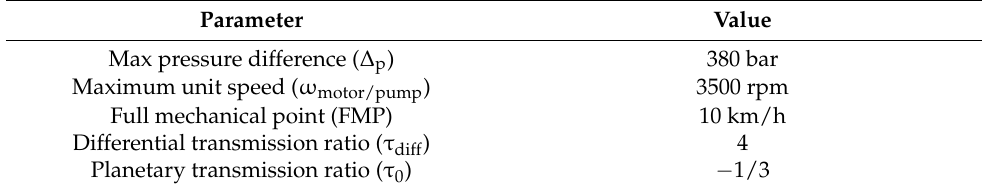
Table 2. Hydrostatic and mechanical system